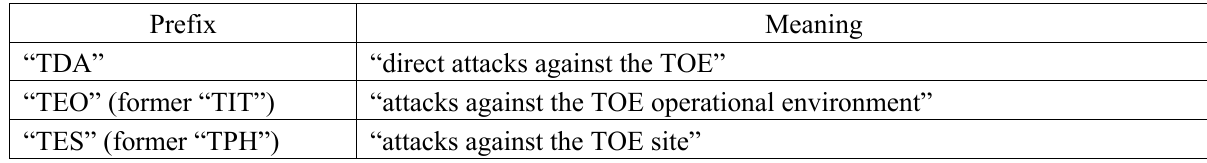
Table 4. Family field defining threats.